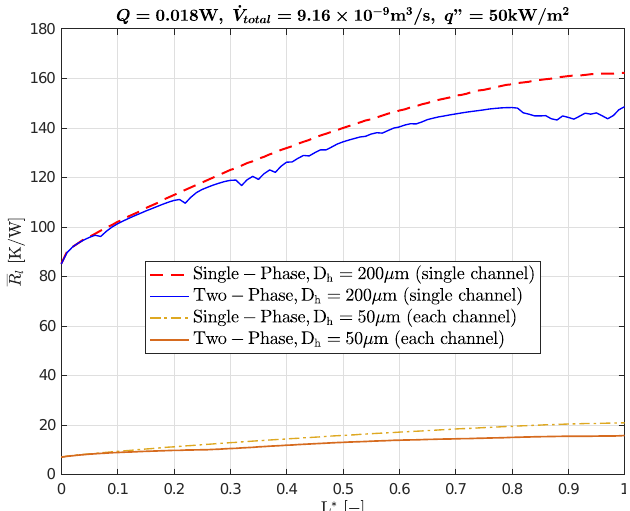
Figure 8. Time-averaged thermal resistance 𝑅̅ 𝑙 comparison of single and two-phase simulations between single channel of D h = 200 μm and four parallels channels, each having D h = 50 μm .